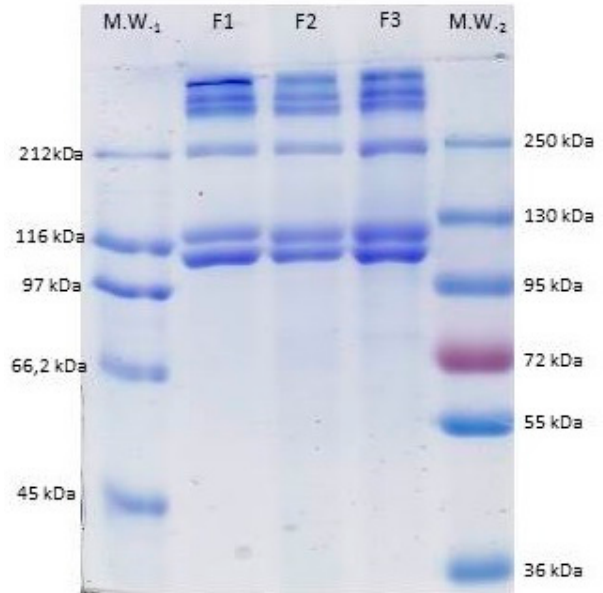
Figure 10. 7% Sodium dodecylsulfate poly-acrylamide gel electrophoresis (SDS-PAGE) profile of F1, F2, and F3 of M. merluccius collagen. M W : molecular weight standards.